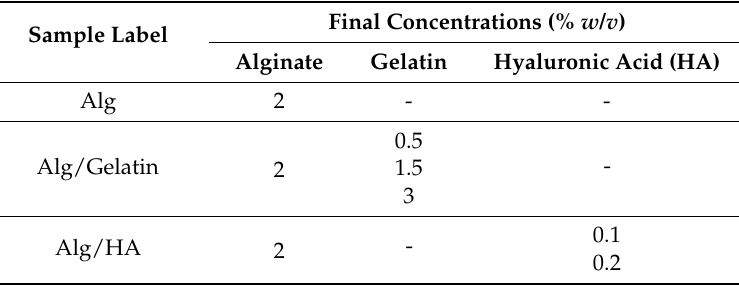
Table 1. Composition of blends for microfibers patch fabrication. Sample